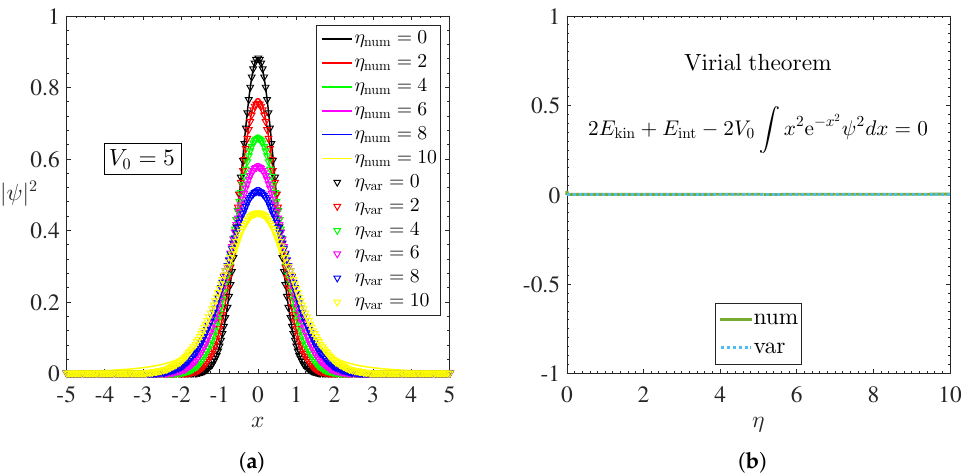
Figure 3. ( a ) Ground states obtained numerically and variationally from Equation (5) for a repulsive BEC of magnons trapped by a Gaussian well for different coefficients of nonlinearity η . Solid lines represent numerical solutions while strings of symbols represent variational solutions. ( b ) Validation of numerical and variational results through the Virial theorem given by Equation